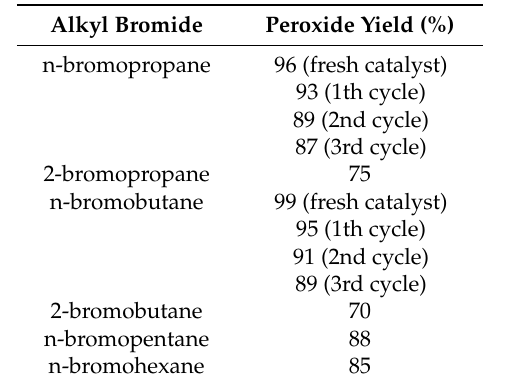
Table 5. The e ff ect of a kind of organic solvent. 1 alkyl bromide, 1.50 mmol; CHP 0.23 g, 1.50